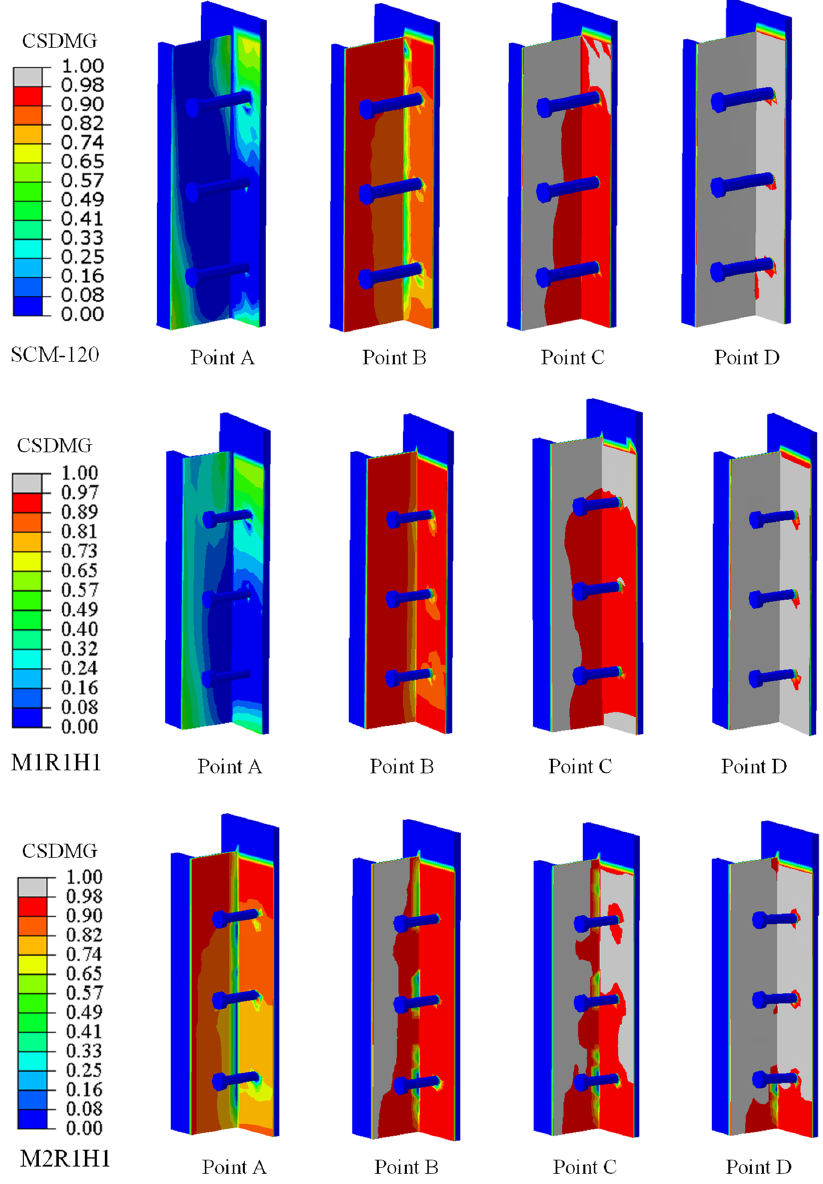
Figure 14. Damage process of the bonded interface.